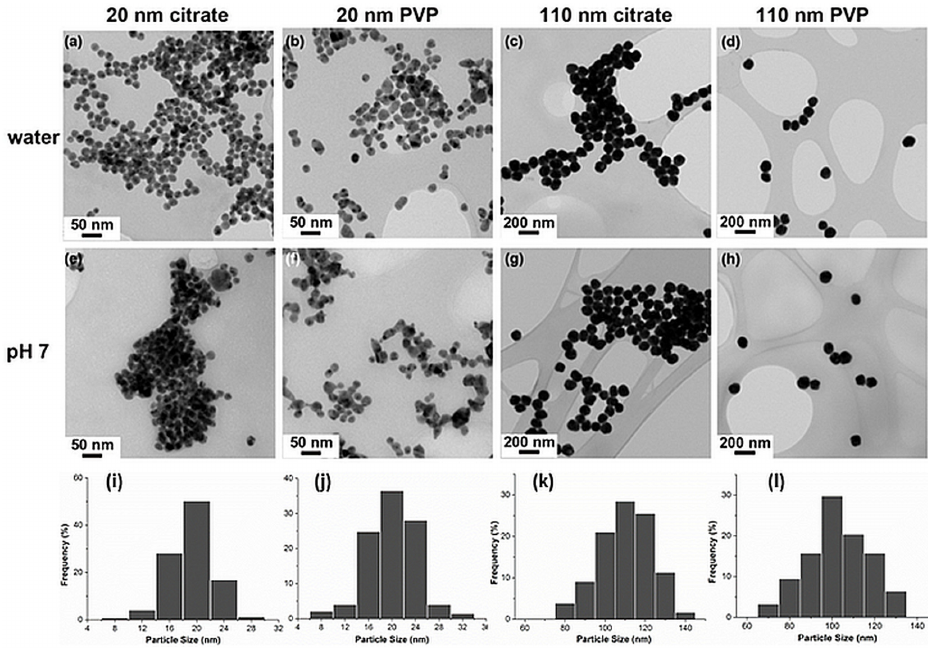
Fig 1. Characterization of AgNP by TEM. TEM images of citrate compared with PVP stabilized AgNPs (20 nm and 110 nm) in ( a — d ) DI water and ( e — h ) incubated in pH 7 perchlorate buffer solution at 37°C for 24 hours (magnification at 20 x); ( i — l ) show the corresponding (i, a and e; j, b and f; k, c and g; l, d and h) size distribution histograms of AgNP in DI water (n = 200 repeat